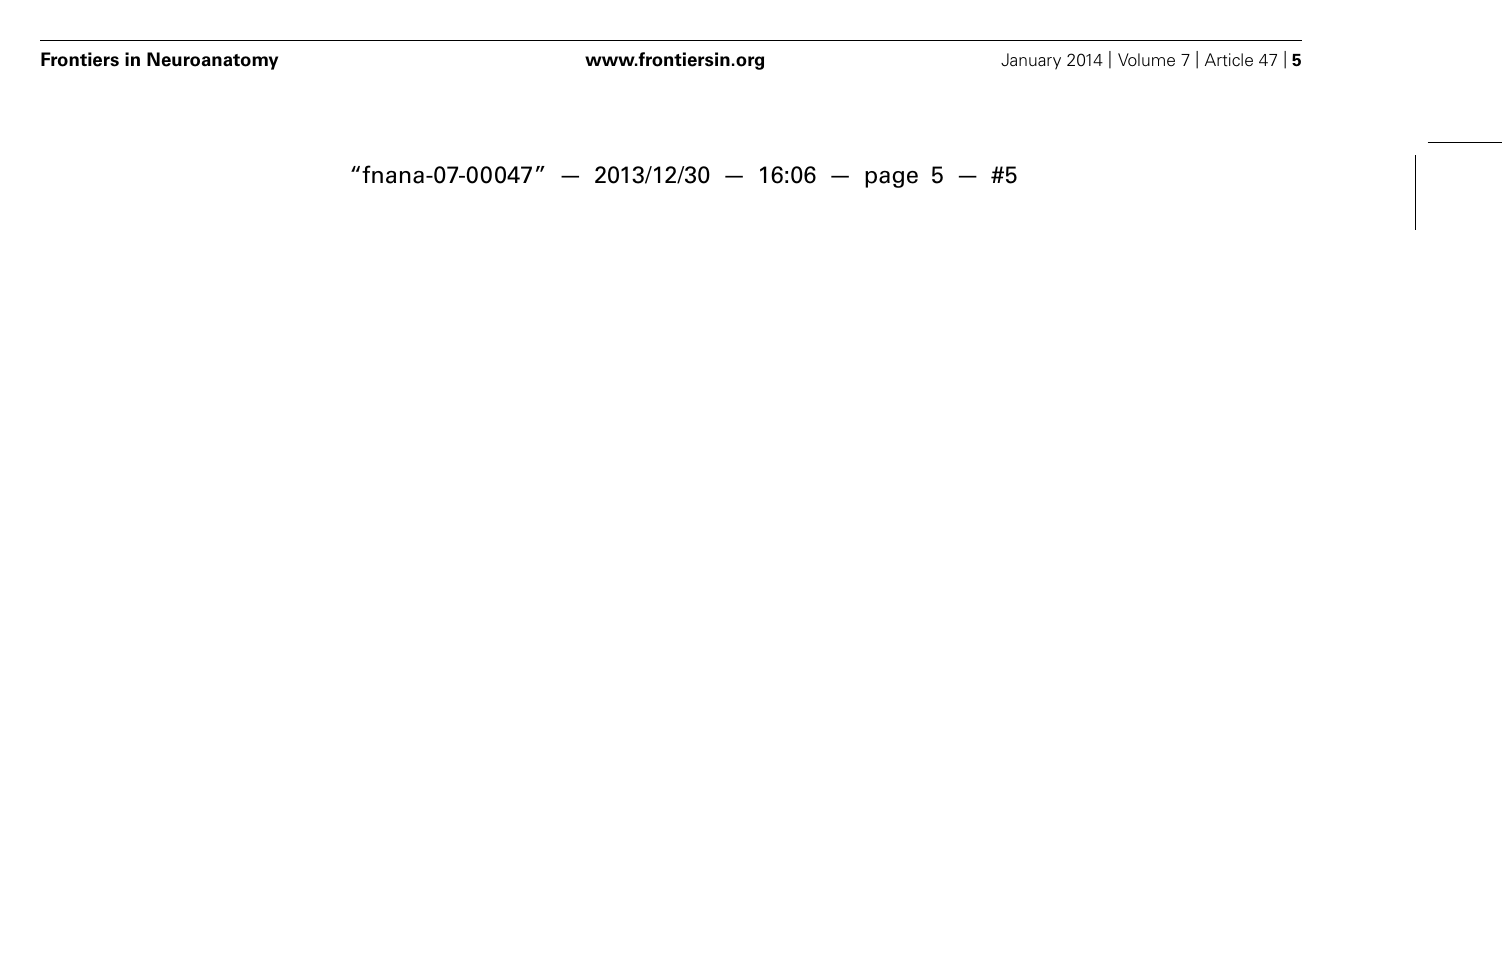
FIGURE 2 | Complementation of certain variants of RVG improve the efficiency of production of HEP- Δ G-GFP. (A) Efficiency of recovery of HEP- Δ G-GFP with four variants of RVG. Only SADG did not increase the probability of HEP- Δ G-GFP production. (B) Numbers of HEP- Δ G-GFP producing cells per well.The numbers in parentheses indicate the numbers of